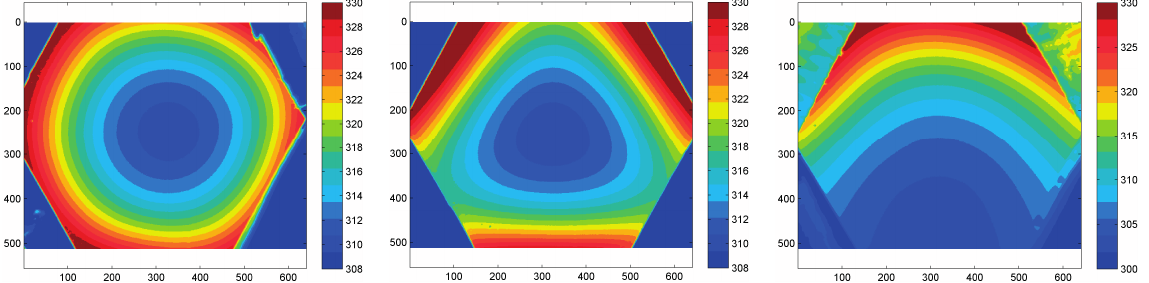
Figure 18. Steady state temperature (K) of the plate without the jet. From left to right: hexagonal heating configuration; triangular; one-side. From Carlomagno et al .